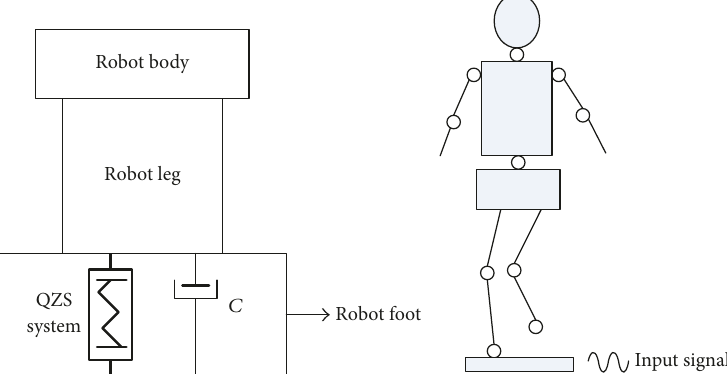
Figure 4: Block diagram of rehabilitation robot quasi-zero-stiffness vibration isolation and whole sketch map.